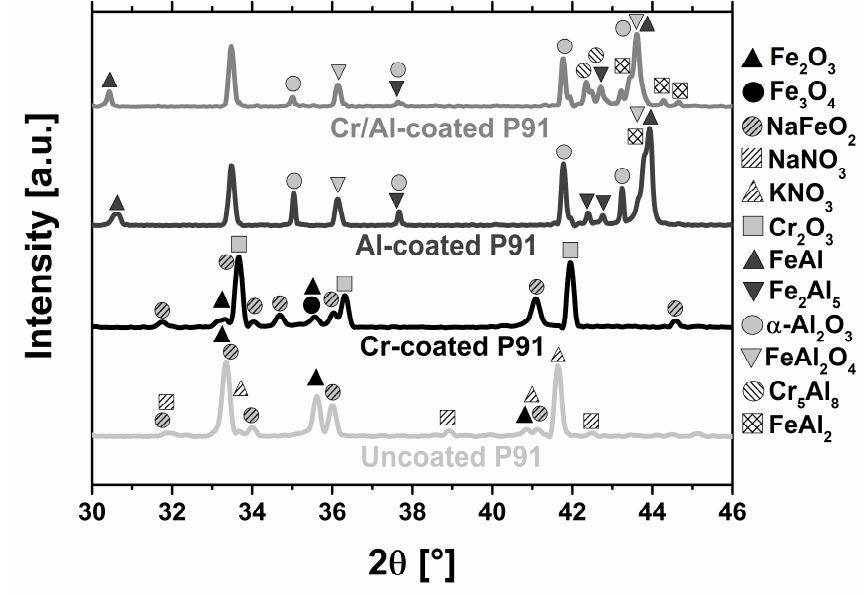
Figure 6. XRD patterns of uncoated, chromized, Al- and Cr / Al-coated P91 specimens after 1000 h exposure in molten solar salt at 600 ◦ C.